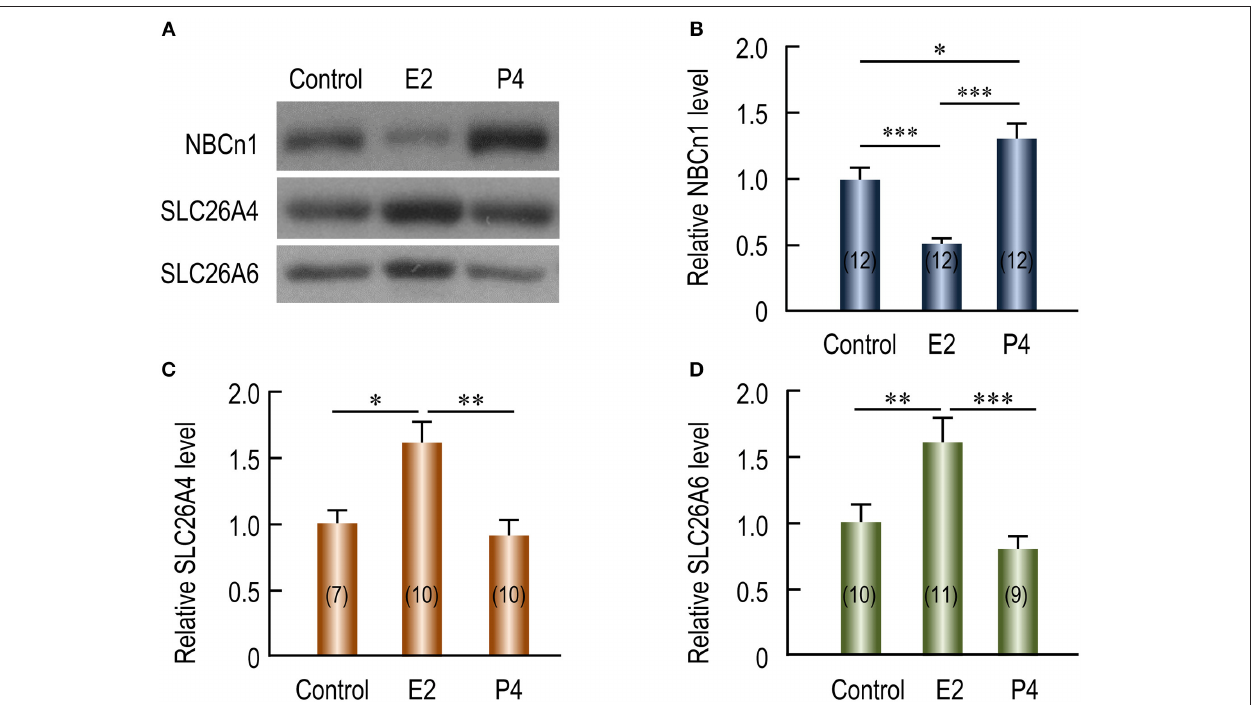
FIGURE 5 | Effects of β -estradiol and progesterone on relative protein abundance of NBCn1, SLC26A4, and SLC26A6 in uteri of ovariectomized mice. (A) Representative western blottings of NBCn1, SLC26A4, and SLC26A6. The ovariectomized mice were injected with sesame oil (control), β -estradiol (E2), or progesterone (P4). Each lane represents the uterus from a single mouse. Equal amount (10 µ g) of membrane proteins were loaded into each lane for western blotting. Full-length blots for the images in A are shown in Supplementary Figures S4A–C. Equal loading was verified by Coomassie staining (see Supplementary Figures S4D). (B–D) Summary showing the effects of E2 and P4 on relative abundance of uterine NBCn1 (B) , SLC26A4 (C) , and SLC26A6 (D) . The bar graphs were created by using a strategy similar to that in Figure 3 . Briefly, raw densitometric density was obtained for the target band in each lane on a specific blot by ImageJ. The raw densitometric densities were then divided by the average density of all “control” lanes on the same blot to create a normalized value, representing the relative protein abundance of the transporter in the membrane preparation. Such normalized values from different blots were pooled to generate the bars in B–D . The data were presented as mean ± SEM. The figures in the parenthesis of each bar indicate the number of mice included in each group. One-way ANOVA followed by Fisher’s post-hoc multiple comparisons was performed for statistical analysis. * p < 0.05; ** p < 0.01; *** p <